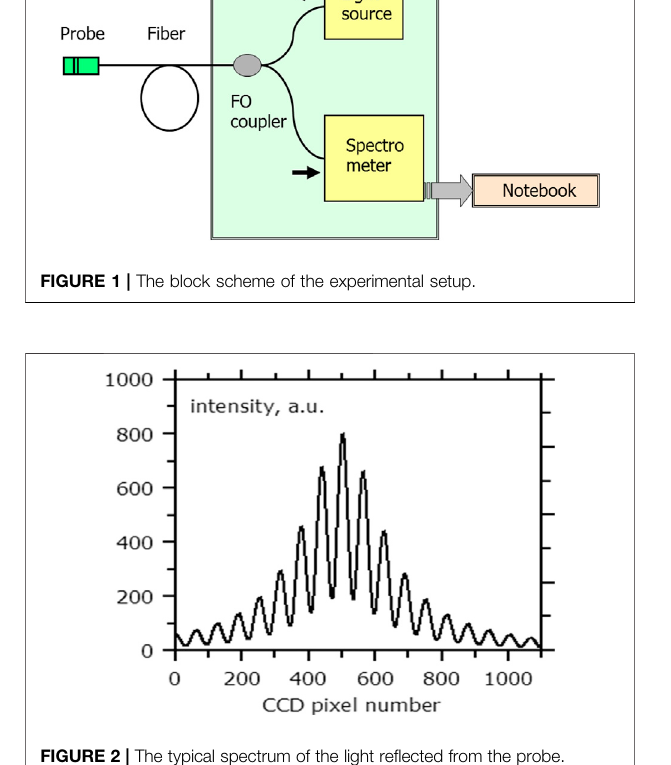
FIGURE 2 | The typical spectrum of the light re fl ected from the probe.